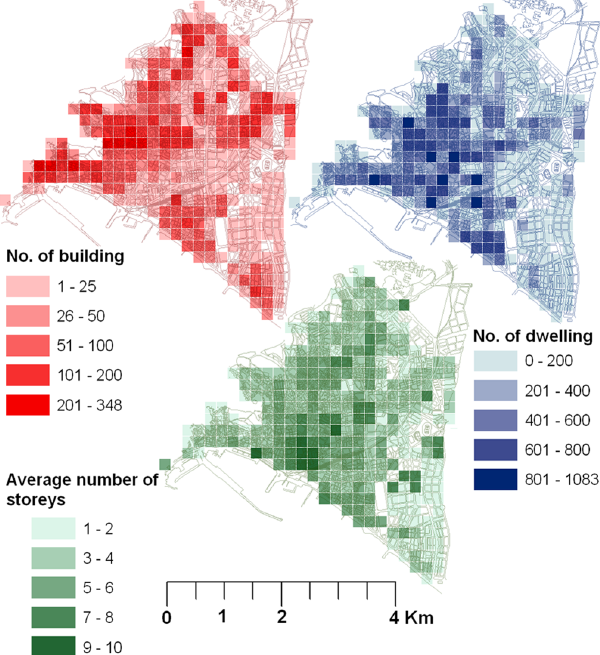
Fig. 4. Geographic distribution of buildings and dwellings per working unit. Geographic distribution of the average number of floors of the buildings per working unit.